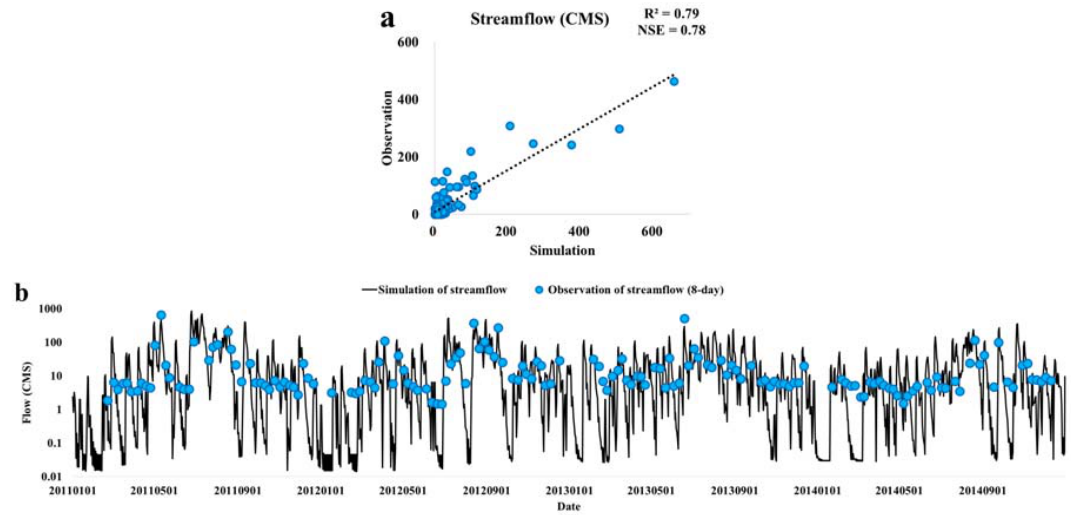
Figure 4. Comparison between simulated streamflow ( a ) and observed streamflow ( b ) at Dalcheon A